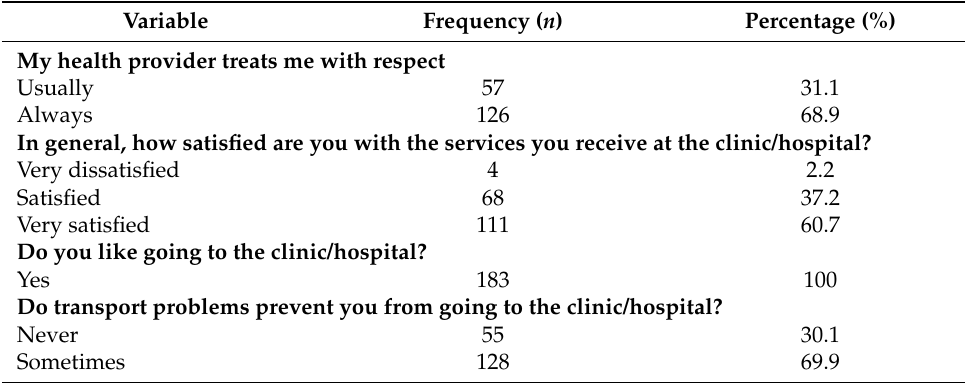
Table 3. AYLWH perceptions of health care services.